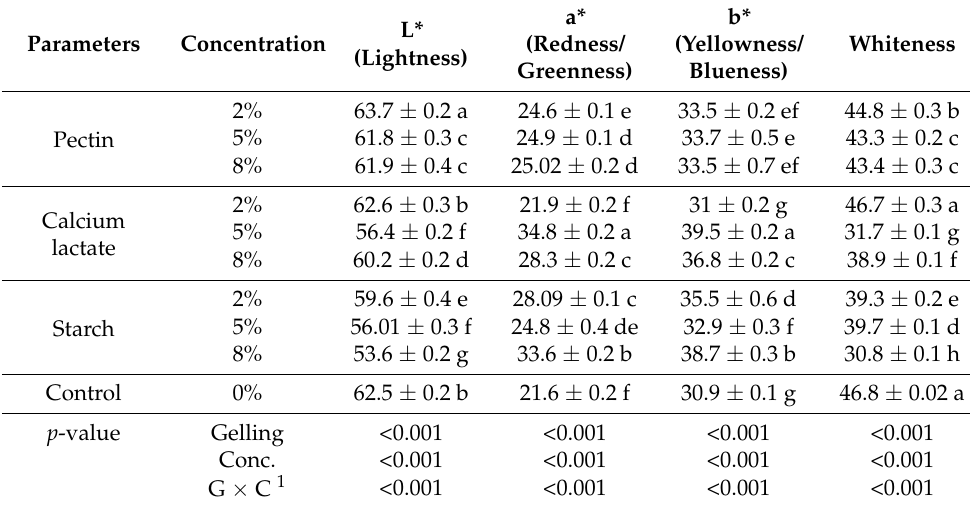
Table 2. Colour analysis of different gelling agent concentrations of gel